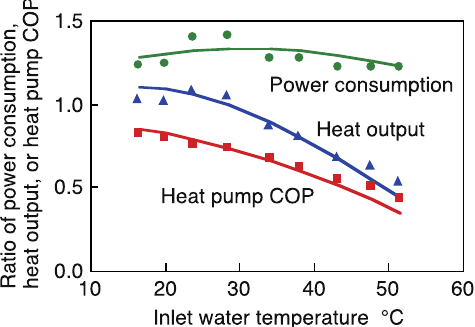
Figure 6. Performance characteristics of CO 2 heat pump. COP: coefficient of performance.